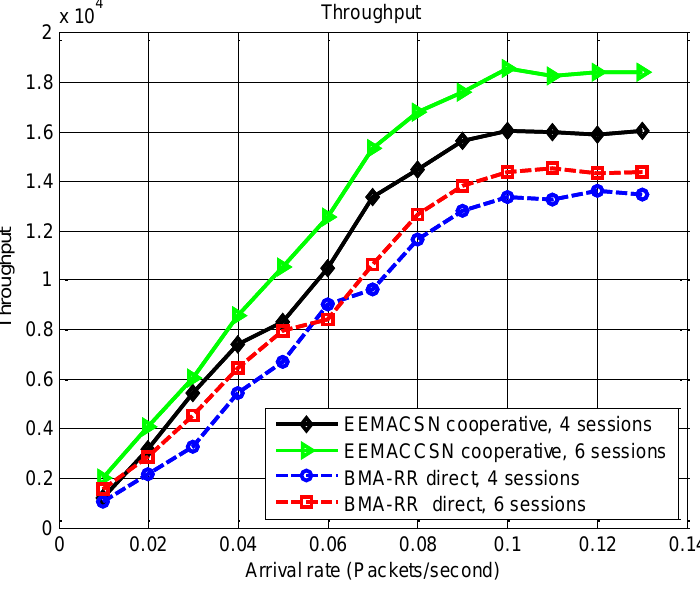
Figure 16. Throughput vs. arrival rate, SNR threshold 9